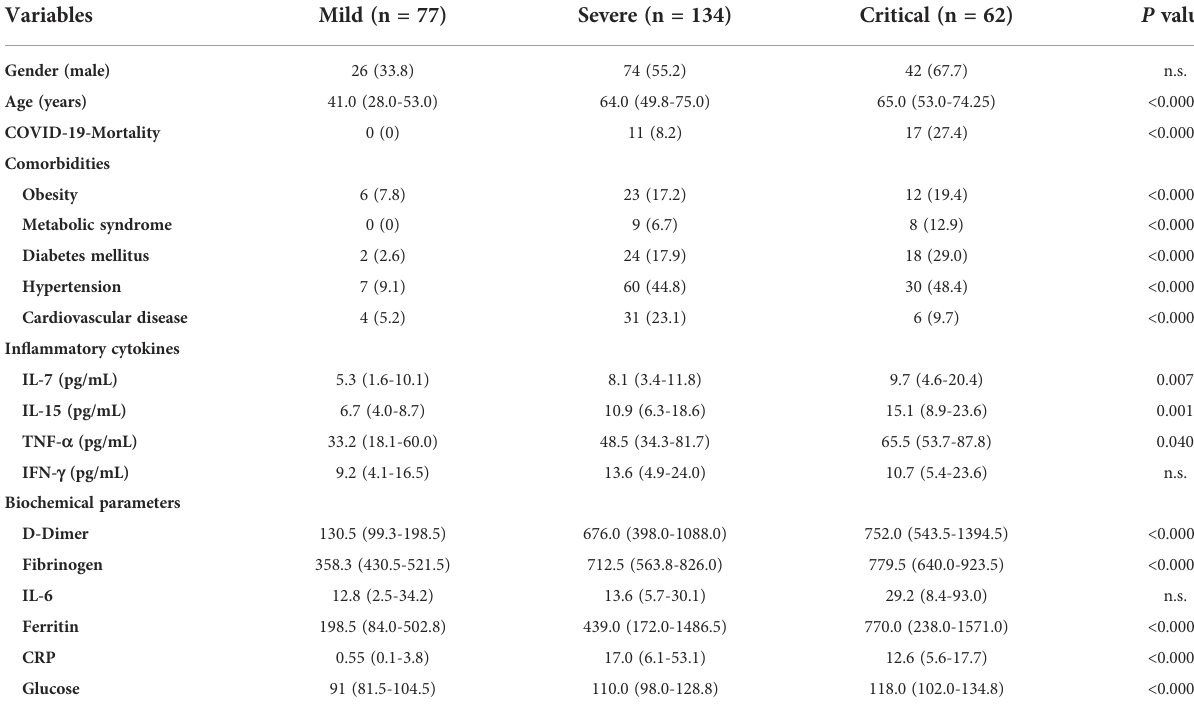
TABLE 1 Patient characteristics of COVID-19 cohort